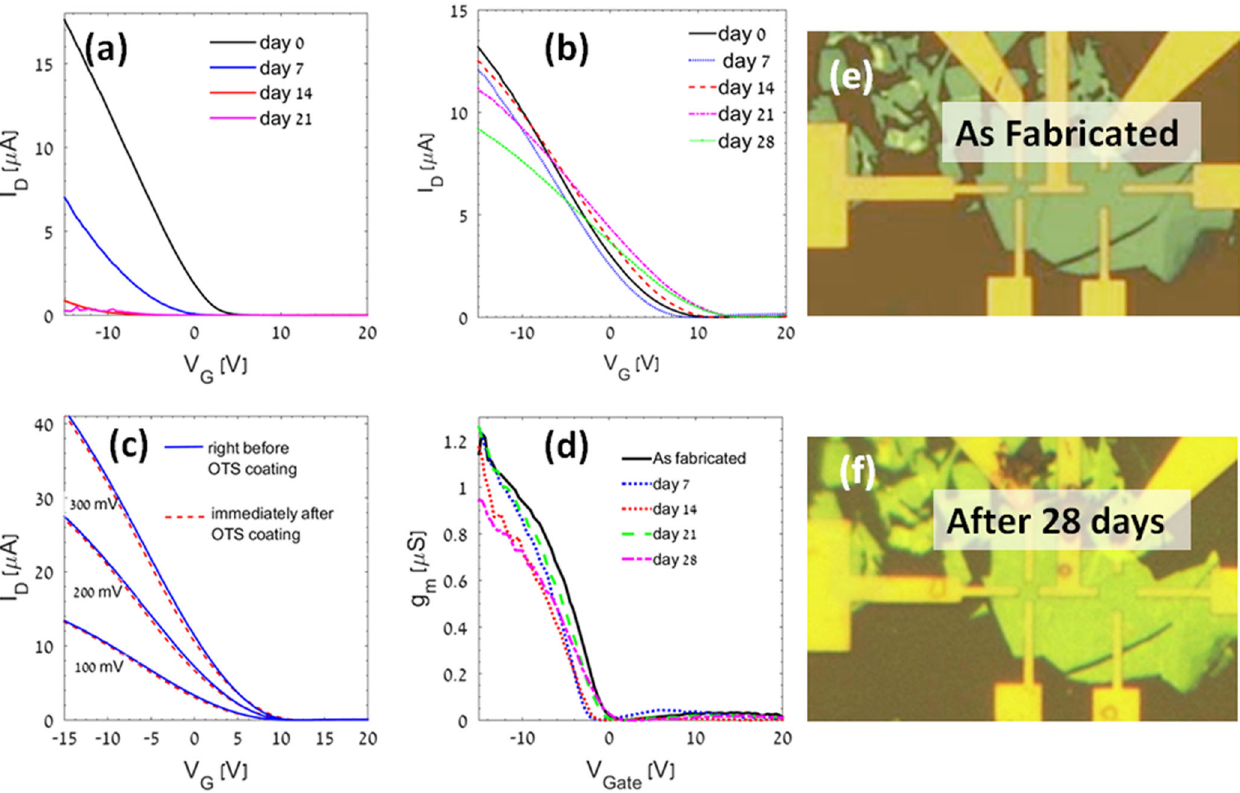
Fig. 2 Current transfer curves of uncoated ( a ) and OTS-coated ( b ) devices, sampled over a period of 28 days in room atmosphere. I – V curves of as-fabricated (uncoated, solid lines ) and right after OTS-coating ( dotted curves ), showing negligible effect of the passivation treatment on device transfer curves ( c ), and device transconductrance ( d ). Optical micrographs of the FET devices before OTS coating ( e ) and 28 days after OTS-coating ( f